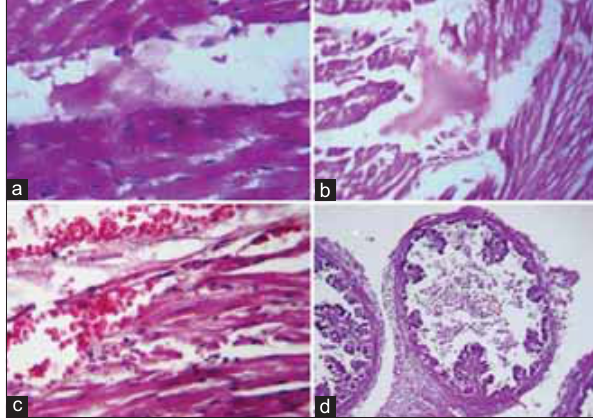
Figure-5: (a) Some areas of heart in rats of 200 mg/kg group were hyalinized, (b) In heart of rats of 100 mg/kg group showed edema, (c) In rats of 25 mg/kg group, mild hemorrhages in epicardium and edema, (d) Severe degeneration changes in fallopian tube of 200 mg/kg dose group, where the mucosal fold were significantly regressed and filled with mononuclear cells.